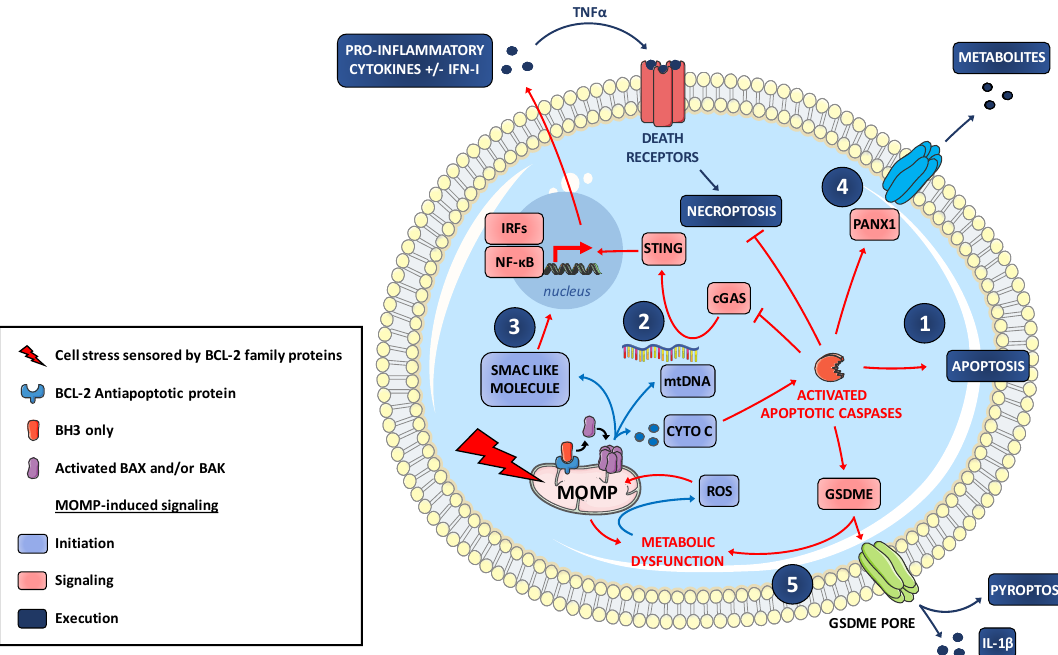
Figure 3. MOMP-induced signaling activation in tumor cells. MOMP-dependent release of factors to cytosol engages various signaling pathways. 1. Cyto-c release leads to apoptotic caspase activation and subsequent apoptosis onset. 2. MOMP-induced mtDNA release activates the cGAS-STING pathway resulting in a pro-inflammatory secretory phenotype when apoptotic caspases are inhibited 3. Release of SMAC like molecules during MOMP promotes NF- κ B activation. MOMP-induced TNF α can promote necroptosis in a context of caspase inhibition. 4. Caspase-mediated opening of pannexin-1 channels at the plasma membrane facilitate the release of a select subset of metabolites. 5. Pyroptosis-induced gasdermin D (GSDME) cleavage triggers mitochondrial metabolic dysfunctions and subsequent ROS accumulation that in turn promotes MOMP-dependent